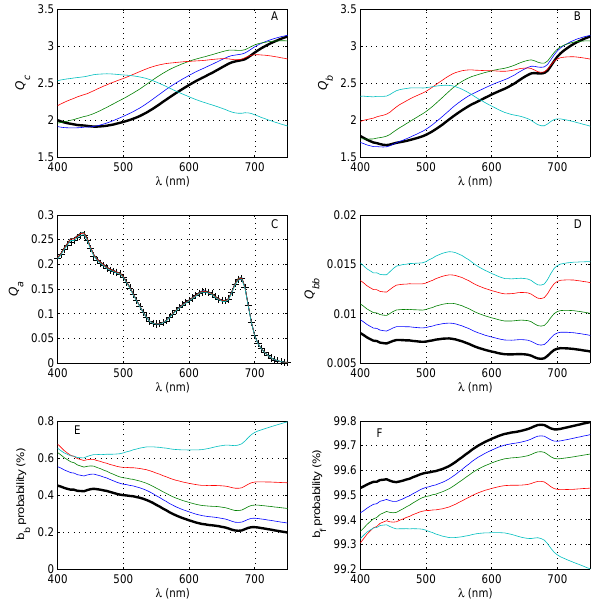
Fig. 3. Optical efficiency factors and forward- and backward- scattering ratios of a population of M. aeruginosa modelled as two- layered spheres with variable gas vacuolation (0–50% cell volume). Legend is the same as Fig. 2. The measured absorption efficiency factor is drawn for comparison in C (+).